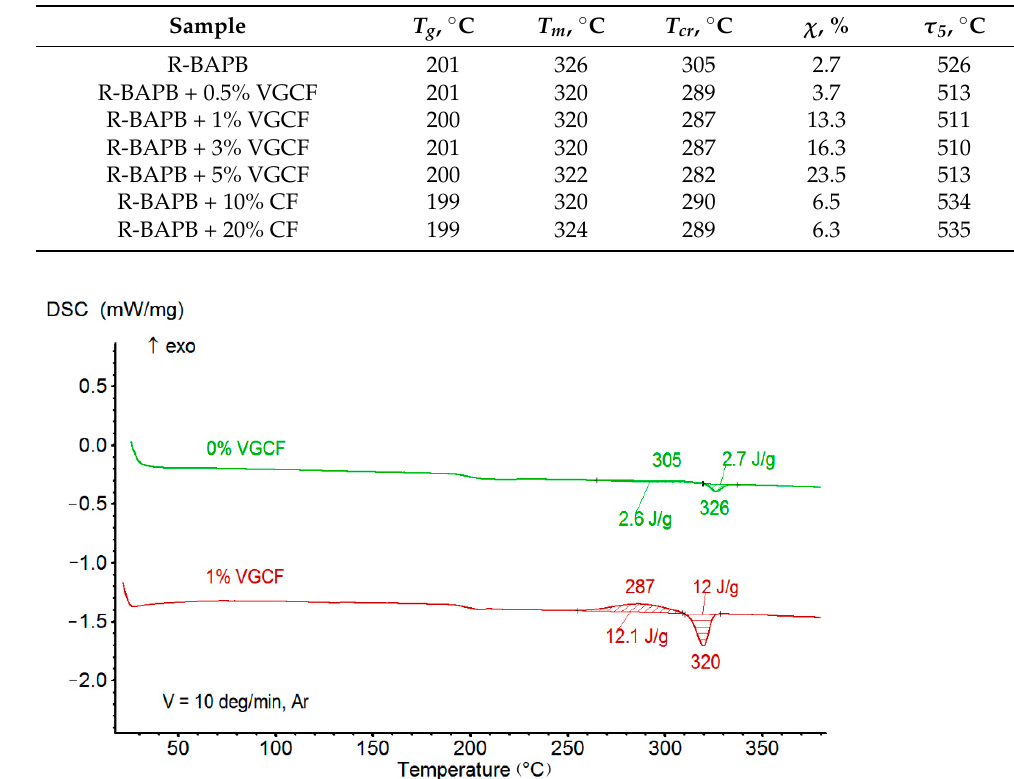
Table 1. The dependence of the thermal properties of the composites based on R-BAPB on the concentration of various fillers. ( T g is the glass transition temperature, T m is the melting point, T cr is the crystallization temperature, χ is the degree of crystallinity, τ 5 is the temperature at the loss of 5% of the sample mass; the deviation for each value did not exceed 0.5%).